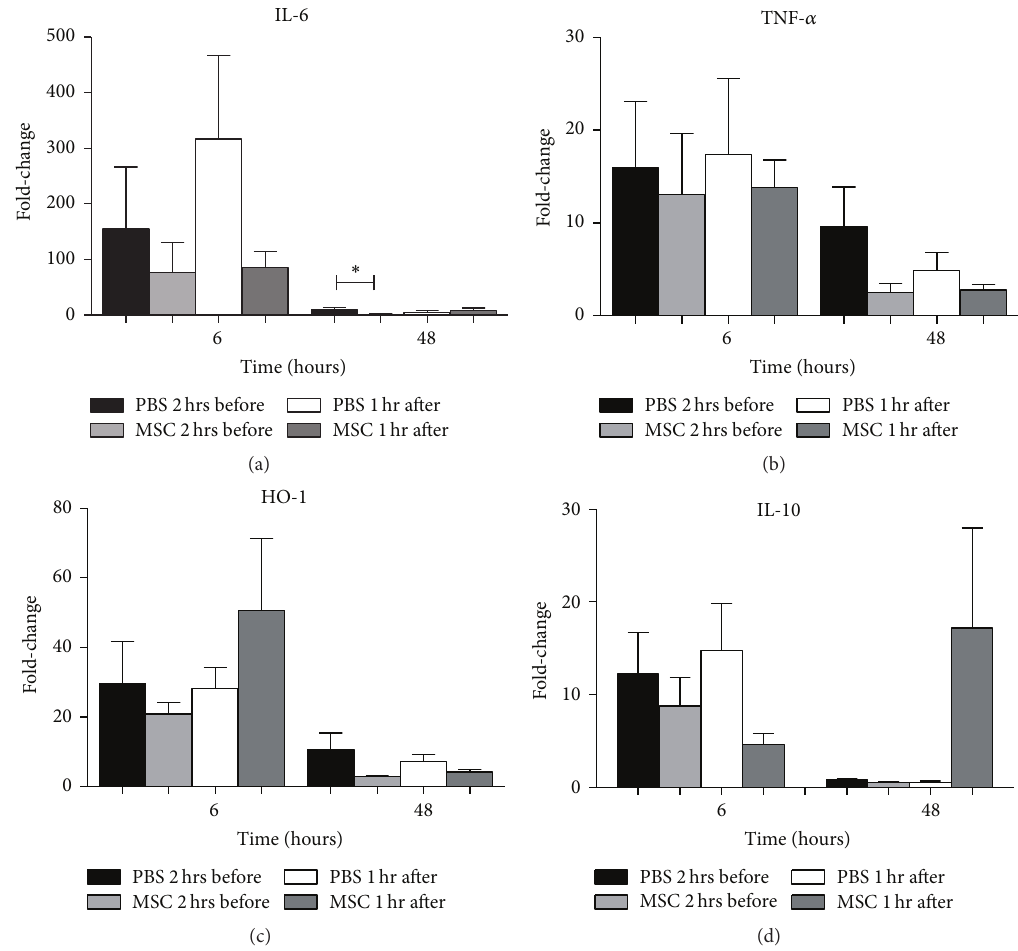
Figure 2: (Anti-)inflammatory and cytoprotective response. (a) mRNA levels of inflammatory marker IL-6 showed no differences six hours after reperfusion. Forty-eight hours after reperfusion mice treated with MSC 2 hours before IRI and PH showed significant lower expression levels of IL-6 compared to PBS treated mice. (b) Inflammatory markers TNF- 𝛼 showed no significant difference after reperfusion. (c) Cytoprotective gene HO-1 showed no significant differences between mice treated with MSC or PBS at both time points. (d) Anti- inflammatory gene IL-10 showed no significant differences between MSC or PBS treated mice. The data are expressed as means ± SEM (( ∗ 𝑃 < 0.05 ) versus their PBS